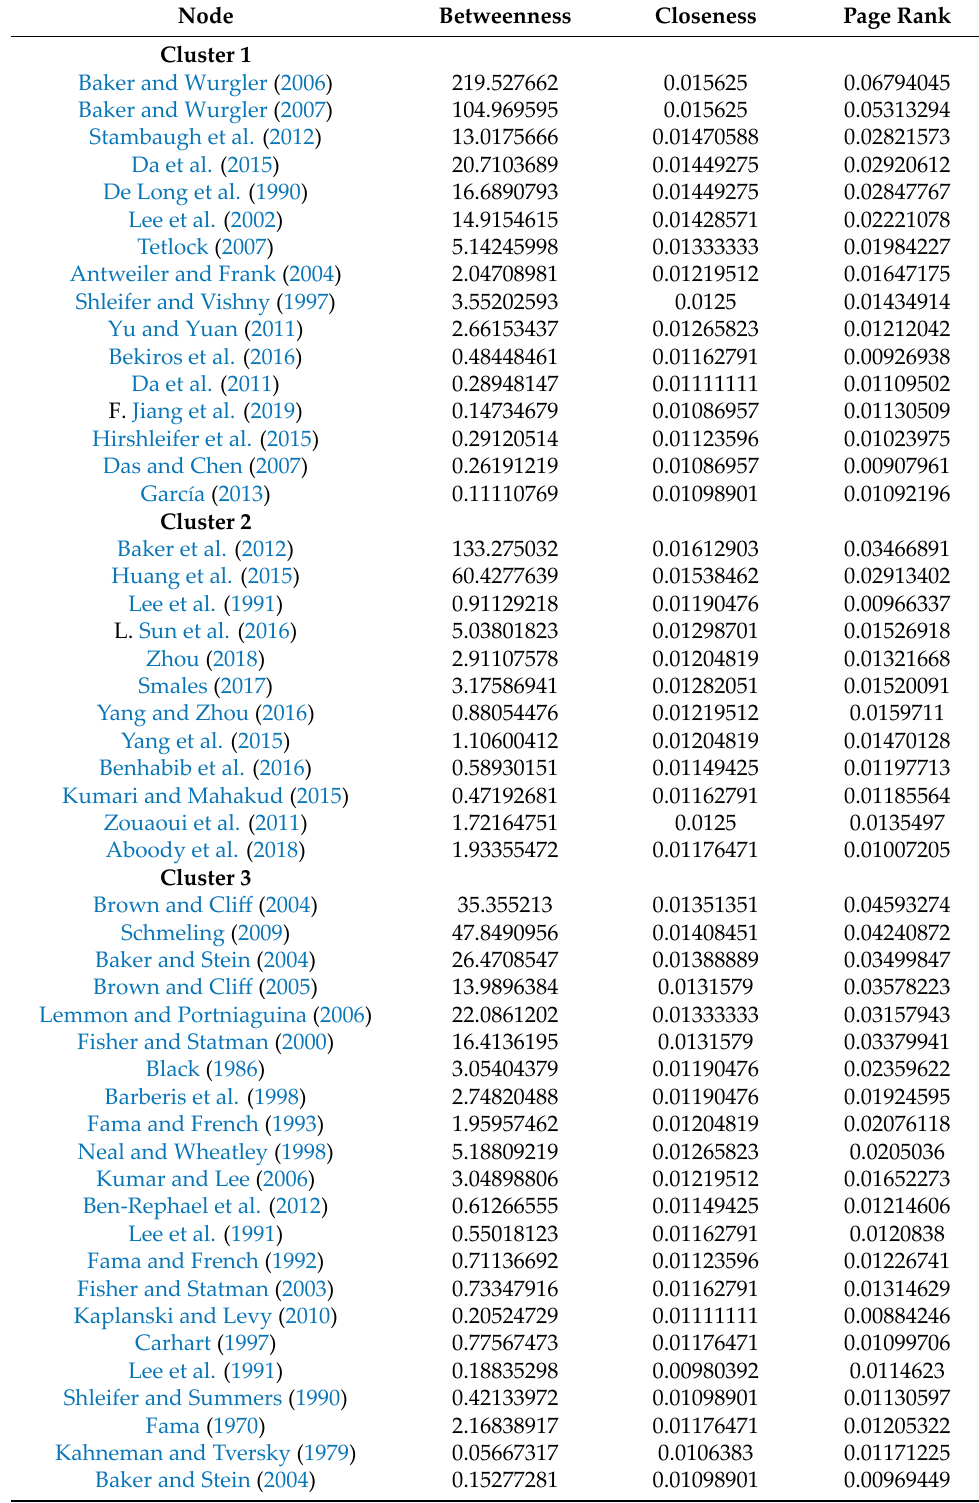
Table A2. Co‑citation